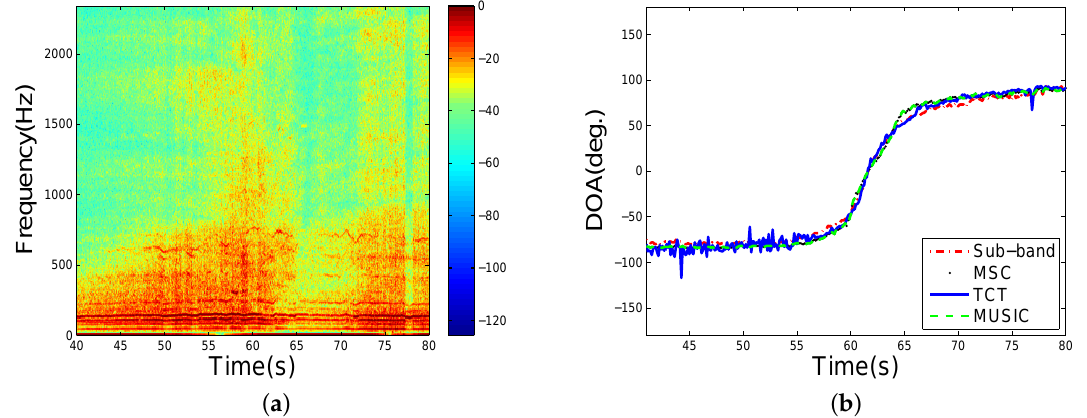
Figure 9. Single vehicle tracking. ( a ) is the spectrum; ( b ) is the estimated DOAs. MUSIC